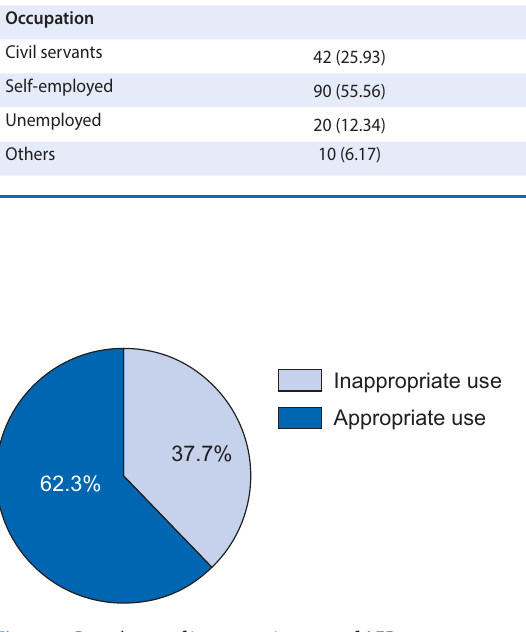
Figure 1: Prevalence of inappropriate use of AED